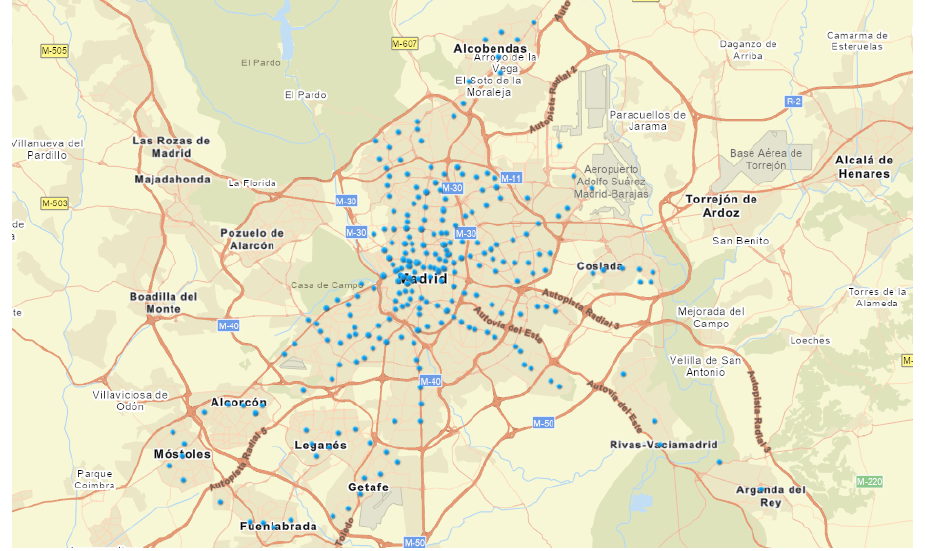
Figure 2. Spatial distribution of Madrid metro stations in 2020 (from